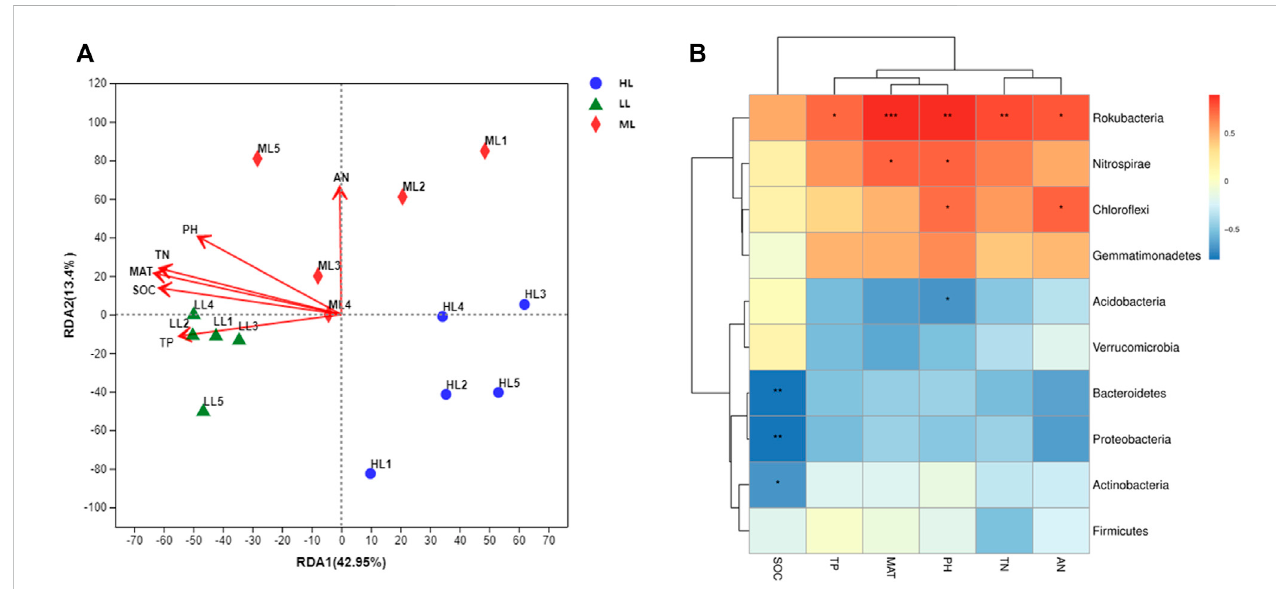
Correlations between soil chemical properties and bacterial phyla. RDA (A) , Heatmap (B) . LL, low-latitude; ML, mid-latitude; HL,